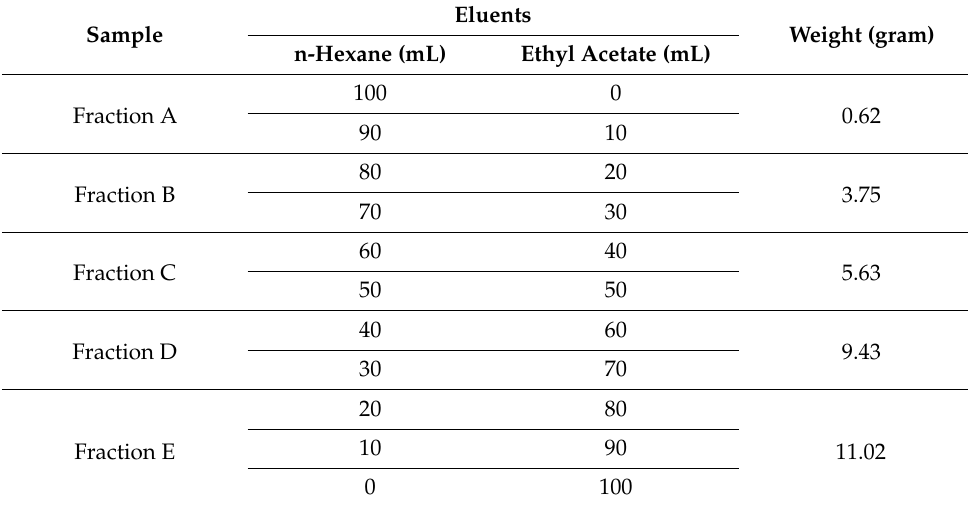
Table 1. Eluent gradient